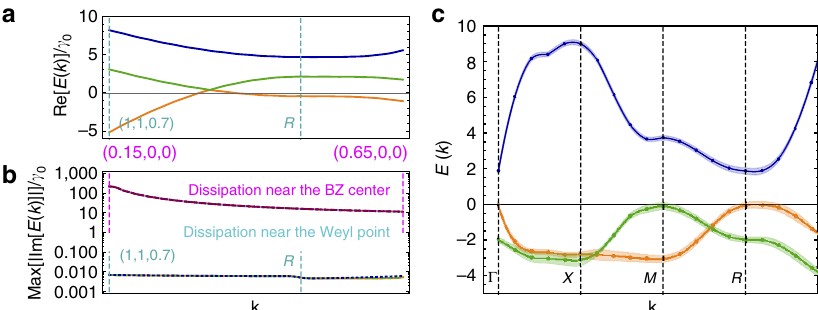
Figure 3 | Effects of disorder and dissipation on Weyl quasiparticles. ( a ) Real part of the quasiparticle dispersion in the presence of dissipation (including spontaneous emission and collective radiative decay). The parameters of the J ¼ 1 2 J ¼ 0 transition correspond to those of the electronic 3 P 0 (cid:3) 3 D 1 levels of bosonic 88,84 Sr atoms, trapped in a magic optical lattice potential with a ¼ 206.4nm (ref. 35) at unit filling. Momentum k is measured in units p / a . ( b ) The upper bound on the inelastic scattering rate estimated from simulating the full quasiparticle spectra including all allowed elastic and inelastic dipolar processes. The dissipation is significantly suppressed near the Weyl node (blue line). In striking contrast, the dissipation is enhanced close to the G point (red line) due to the enhanced collective emission (superradiance). ( c ) Disordered case: quasiparticle dispersion for a lattice with filling